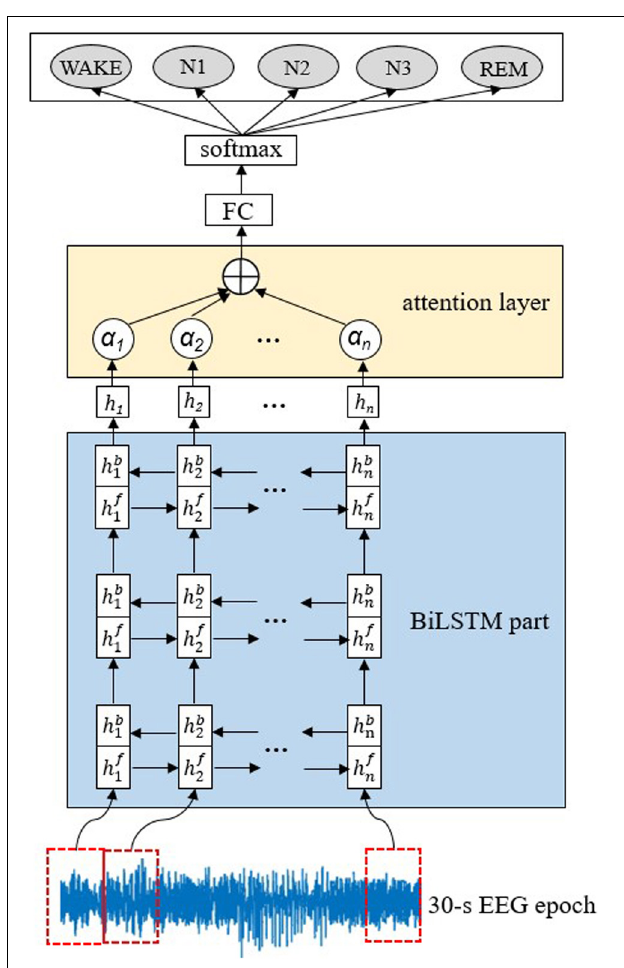
FIGURE 1 | Illustration of the proposed AT-BiLSTM network architecture for automated sleep staging. The network consists of a BiLSTM part, an attention layer, a full-connected (FC) layer and a softmax layer. The input of the network is a raw 30-s EEG time series and the output is the probability of each sleep stage. The dashed rectangle on the EEG time series represents a vector of EEG signals at a time